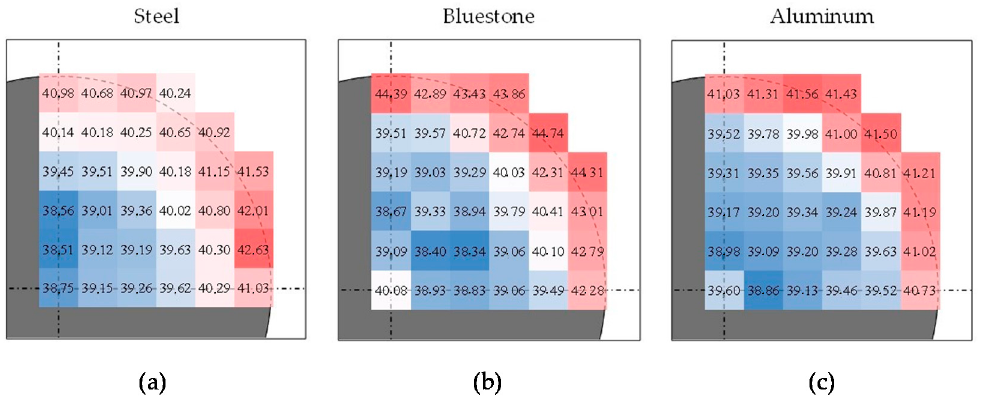
Figure 19. Characteristic fiber content distribution pattern for disc segments of 40 wt.% initial nominal fiber content: steel tool ( a ), Bluestone tool ( b ), and aluminum tool ( c ). The color scheme describes values below (blue) up to values near (white) and values above (red) the initial nominal fiber content (in accordance with Figure 8).